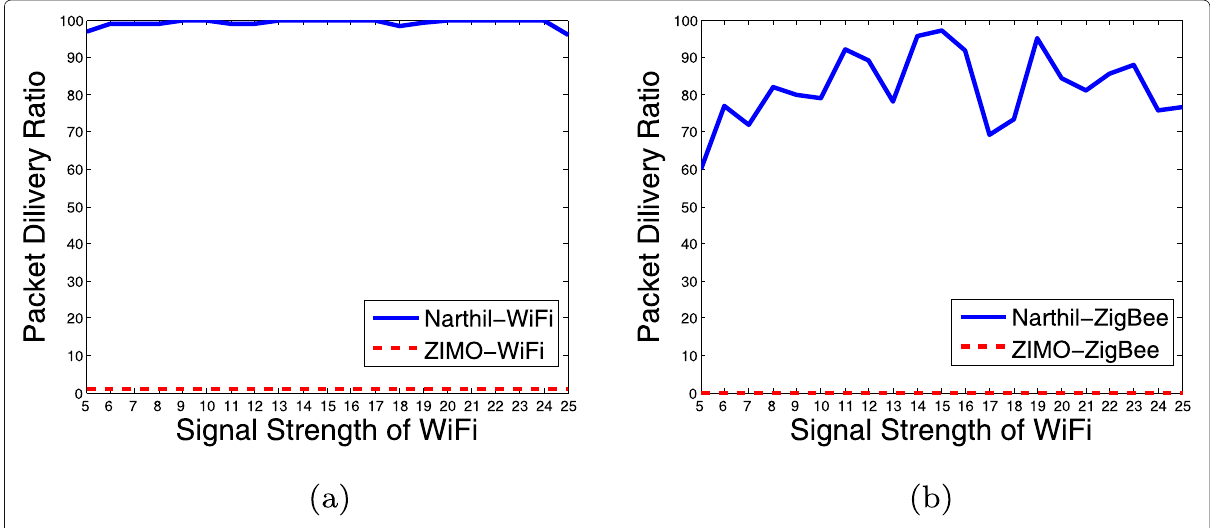
Fig. 20 System performance in the absents of clean preamble. a WiFi decoding performance. b ZigBee decoding